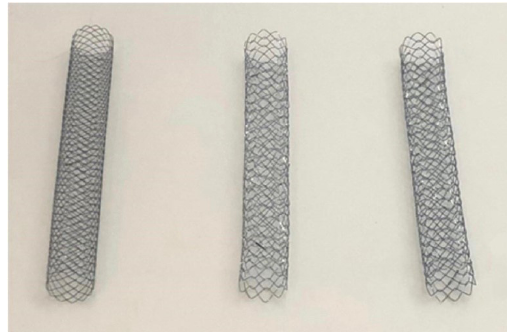
Figure 1 - Fully deployed self-expanding metal stents. From left to right: S-type stent (wire diameter, 0.006 inches), D-type stent (wire diameter, 0.006 inches), and D-type stent (wire diameter, 0.007